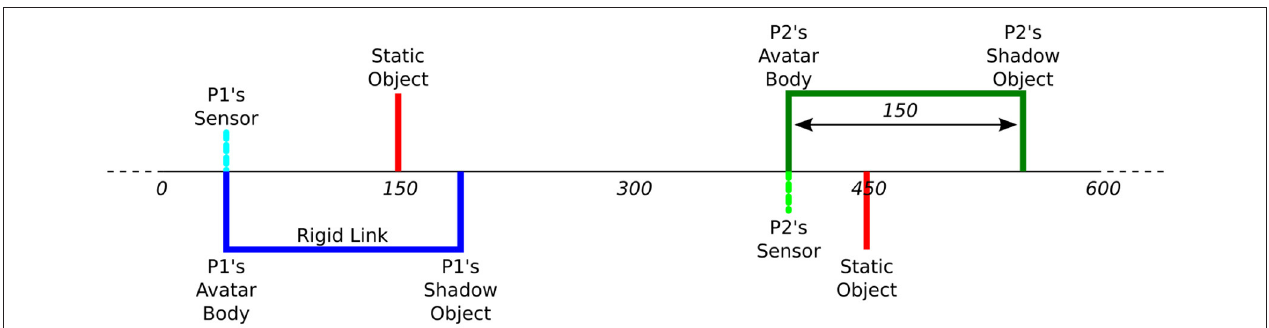
FIGURE 2 | Virtual space in the Perceptual Crossing Paradigm, including the participants’ avatars, static objects, and shadow objects. Note that each participant can feel only one static object, as indicated by the positioning of their sensor. Copied from Froese et al. (2014a) under CC BY 3.0.